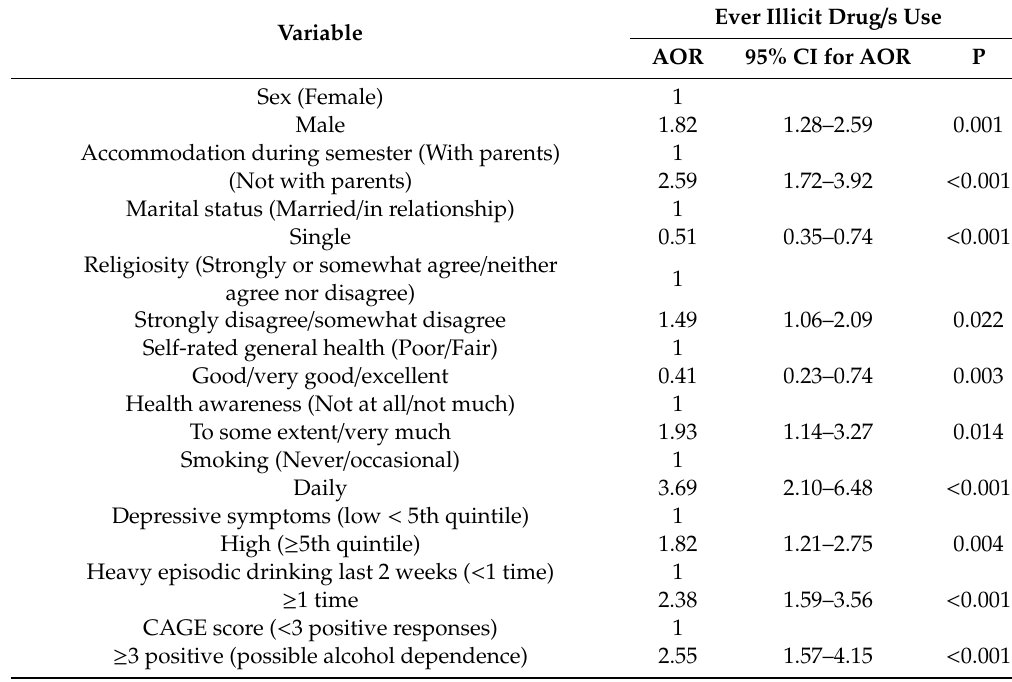
Ever Illicit Drug / s